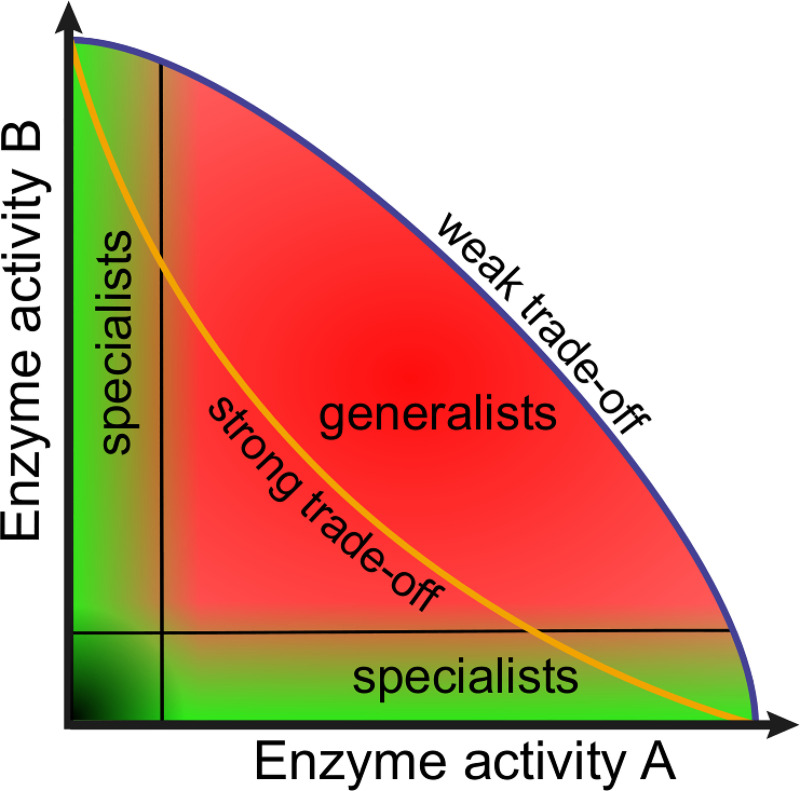
The types of replicators in the two dimensional space of enzymatic activities.Coloured regions represent parts of the phenotypic trait-space which replicators are permitted to occupy by the trade-off constraints. The concave orange line represents a strong trade-off, while the convex blue line stands for a weak trade-off between enzymatic activities A and B. Specialists (replicators in the green areas) have only one significant enzymatic activity; generalists (red area) feature both activities. Replicators of very weak or no catalytic activity are parasites (black area). While the generalist-specialists continuum is gradual, we distinguish them by artificial boundaries defined by a threshold value m = 0.01 (represented by black lines).